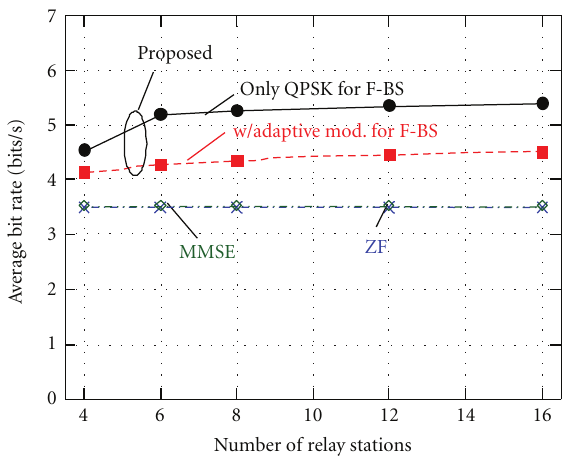
Figure 13: Transmission rate versus transmit power of F-BS when considering shadowing e ff